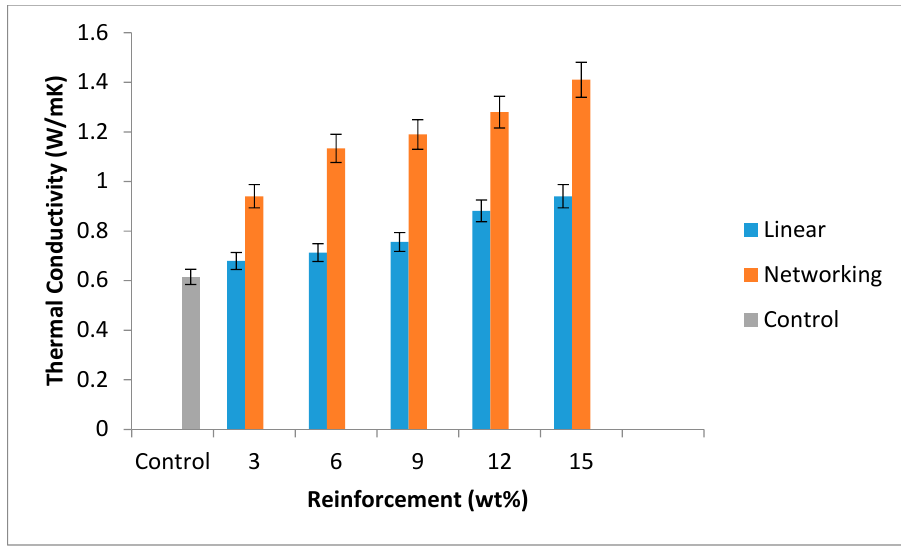
Figure 8. Variation of the thermal conductivity result against percentage composition samples of both the linear and networking layer as well as the control sample.